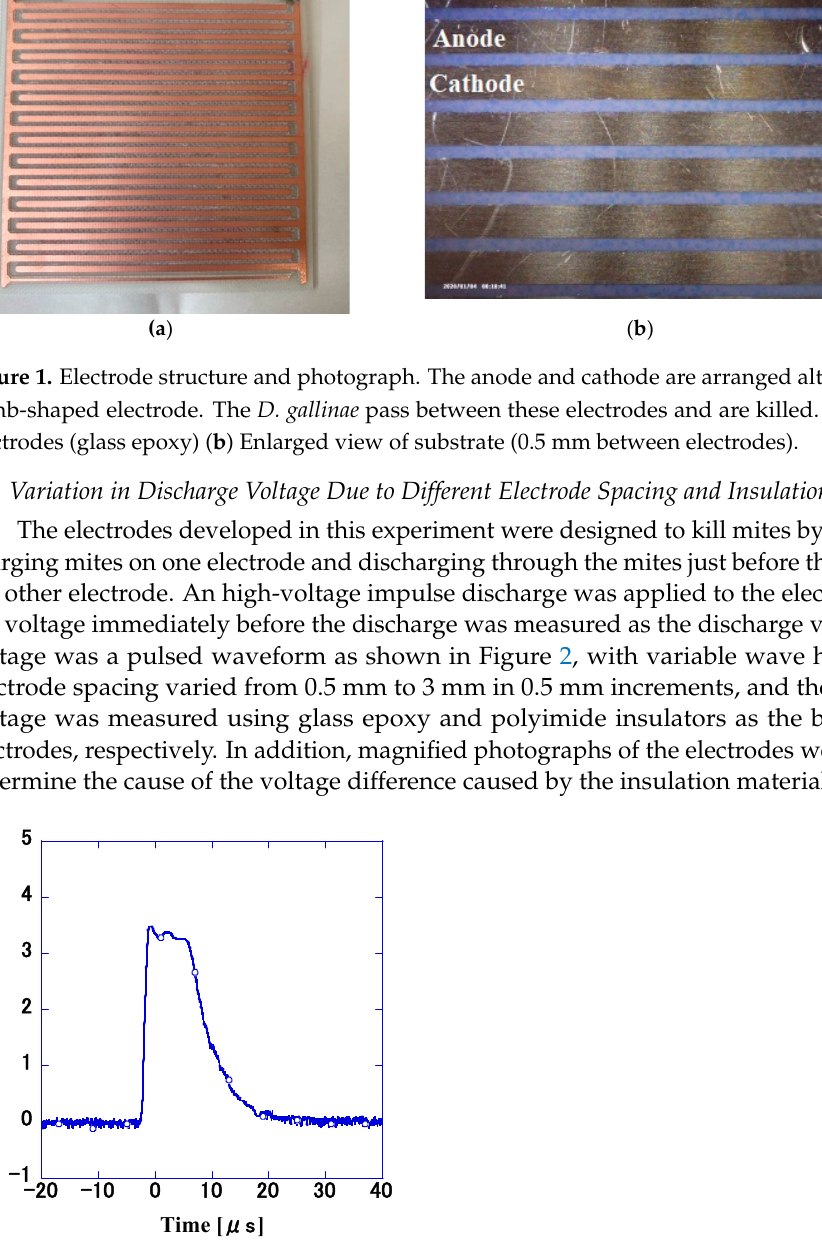
Figure 2. Voltage waveform. Voltage wave height was 3.5 kV; pulse width (FWHM) was 10 µs.